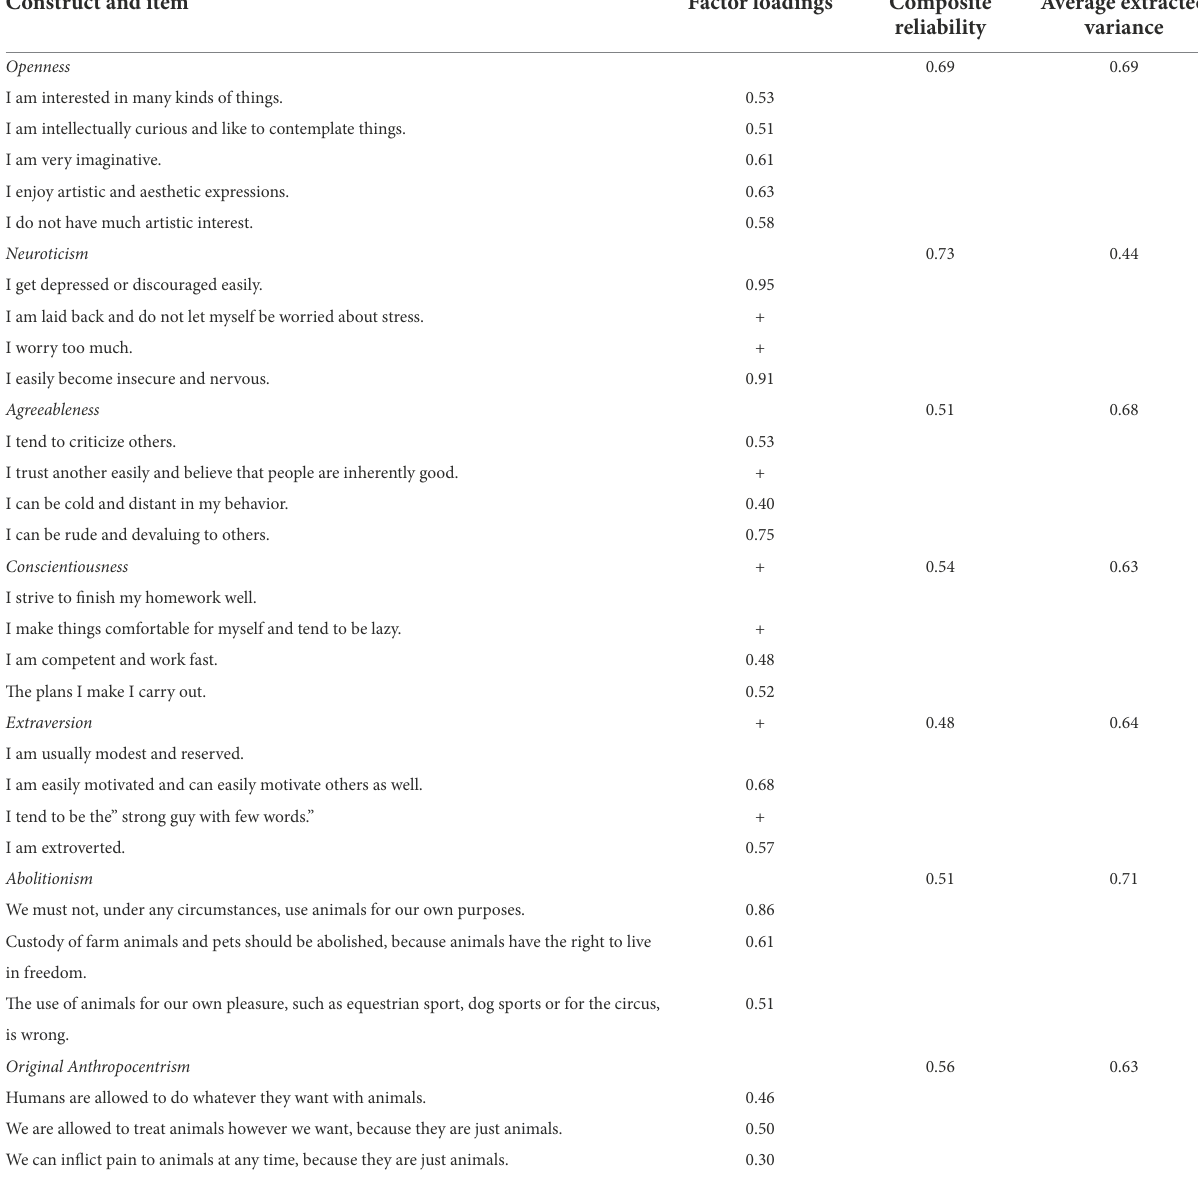
TABLE 1 Standardized factor loadings, reliability, and